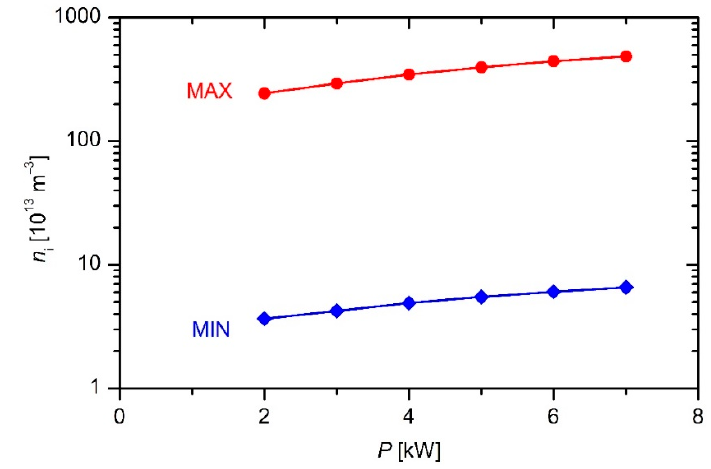
Figure 4. The limits of the plasma density versus the discharge power at an HMDSO flow of 130 sccm.